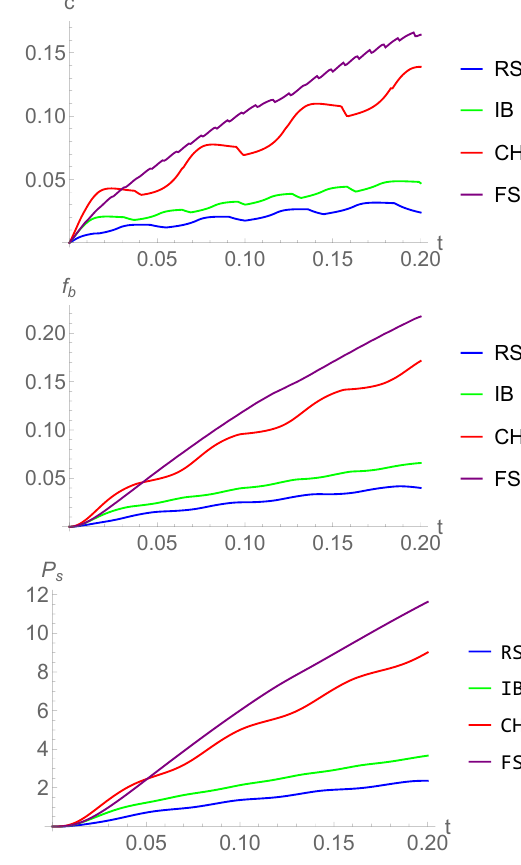
Fig. 3: Concentration of free Ca, bound Ca, and gener- ated muscle